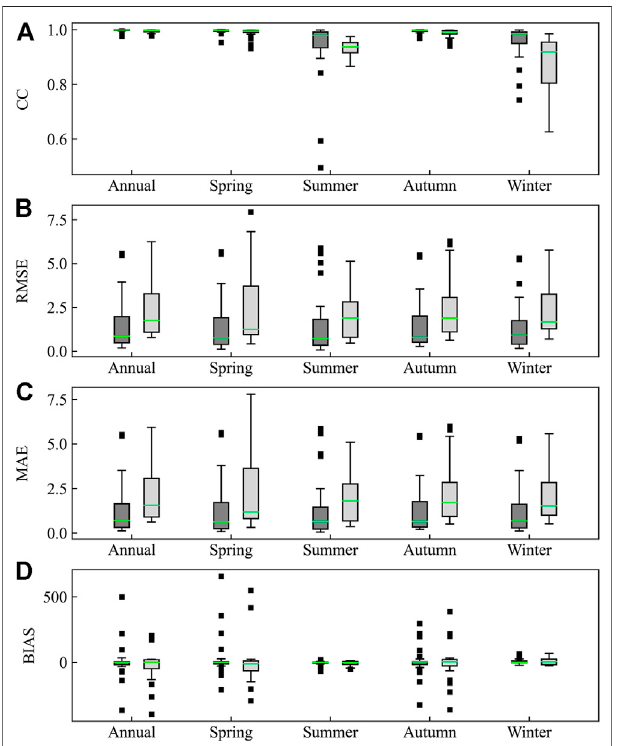
FIGURE 9 | Boxplots of the statistical metrics [CC (A) , RMSE (B) , MAE (C) , and BIAS (D) ] forCMFD and ERA5-Landmonthlytemperature against 28 observation stations data. Five lines from bottom to top for one box represent minimum value, 25th percentile, 50th percentile, 75th percentile, and maximum value, respectively. The blackspot inside the box represents the mean values.